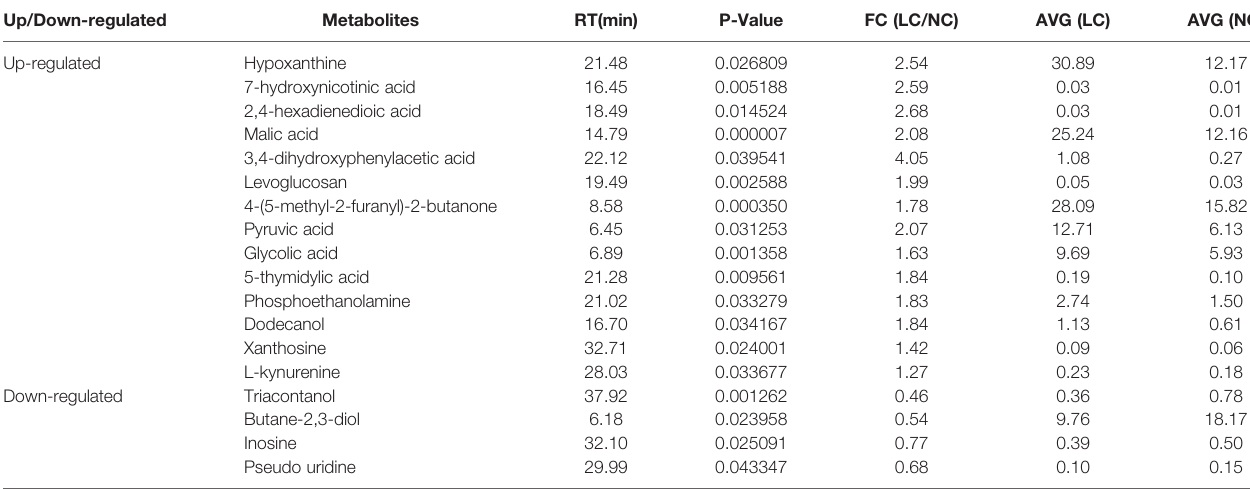
TABLE 2 | Signi fi cantly differential metabolites in gills of LCvsNC group. Up/Down-regulated Up-regulated